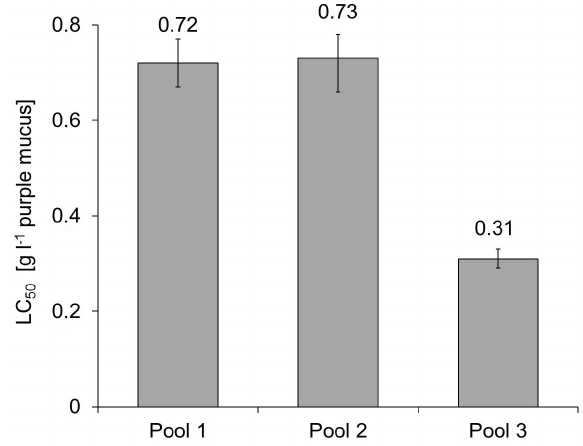
Fig. 2. – Acute toxicity bioassays with Dinophilus gyrociliatus . Median lethal concentrations (LC , with 95% confidence intervals) 50 after 96 h of exposure to the purple mucus of H. parthenopeia